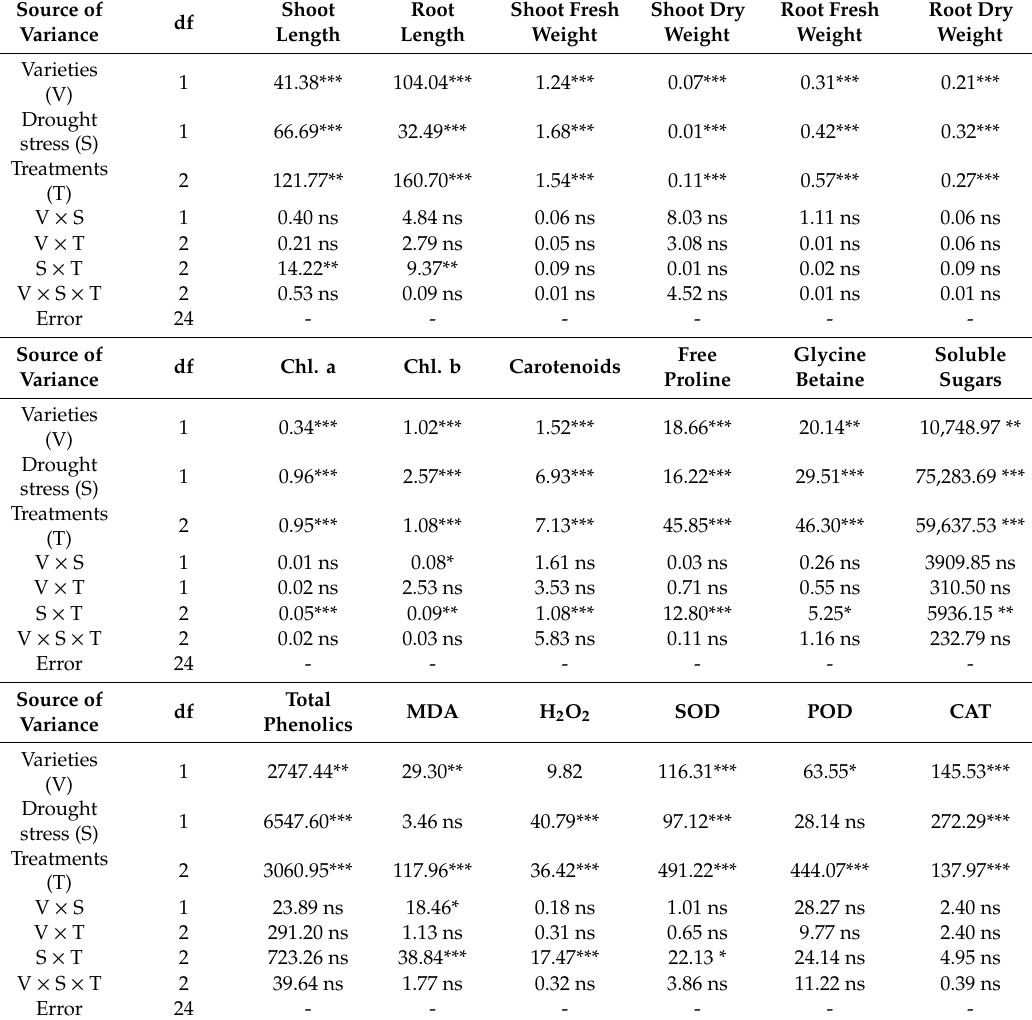
Table 1. Summary of ANOVA regarding the e ff ect of silicon priming on growth, photosynthetic pigments, and oxidative defense in two maize cultivars under drought stress